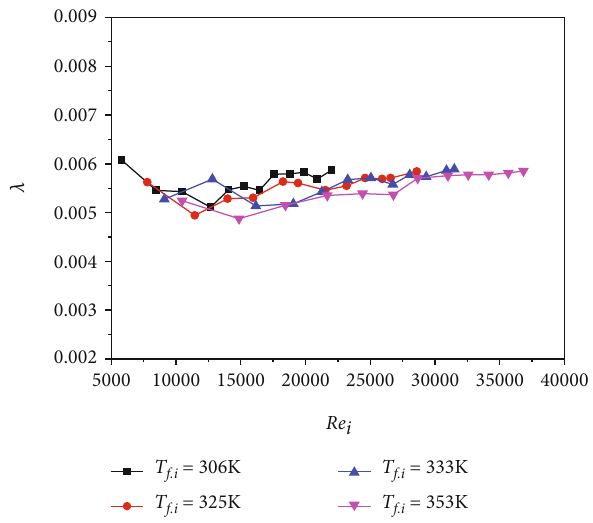
Figure 14: Variation of total pressure loss coe ffi cient of main fuel circuit.